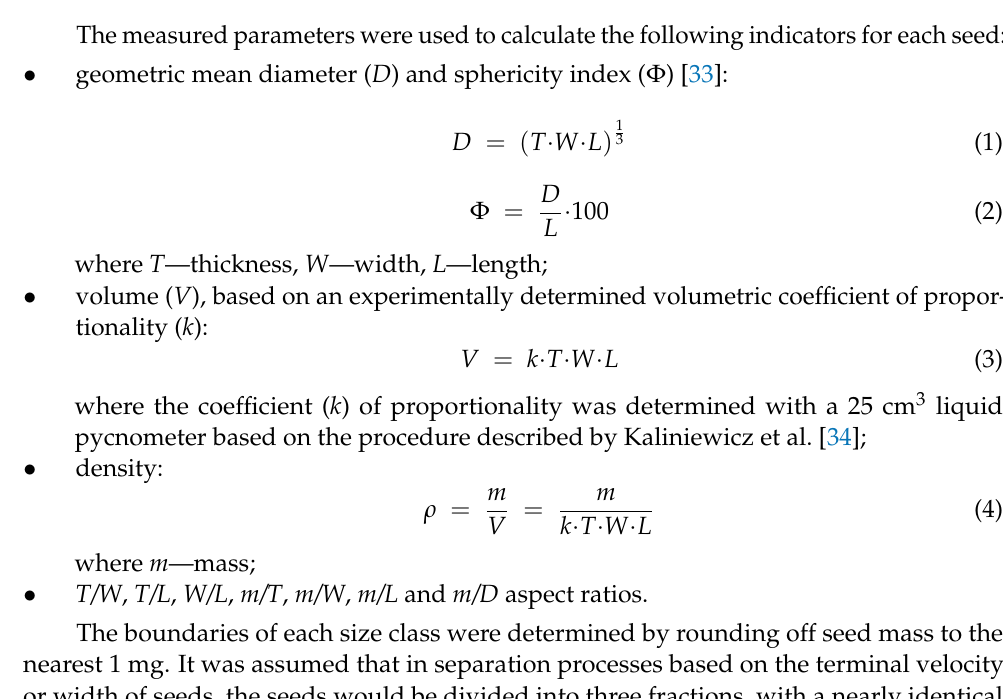
Figure 1. Seeds of ( a ) Viburnum dasyanthum , ( b ) Viburnum lantana , ( c ) Viburnum lentago , ( d ) Viburnum opulus , ( e ) Viburnum rhytodophyllum and ( f ) Viburnum sargentii .